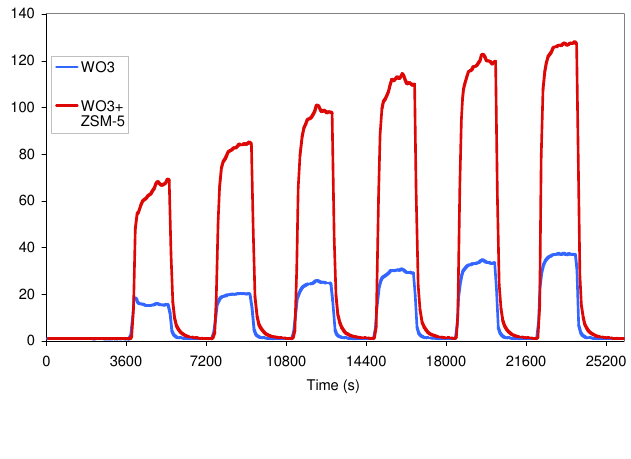
in dry air at 350 °C. 2